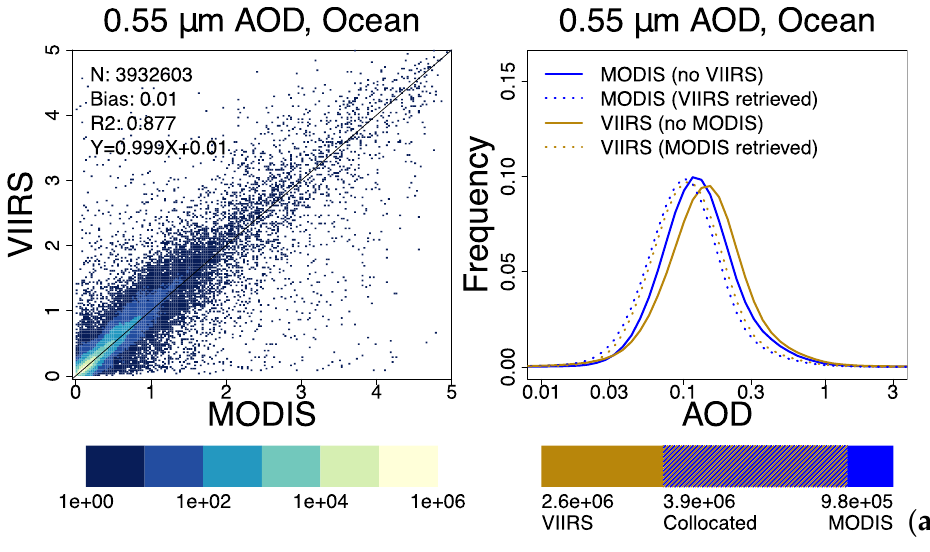
Figure 4. Annual average difference between VIIRS SNPP and MODIS Aqua 0.55 μm AOD on a one - degree grid for 2015. The mean of all grid cells is